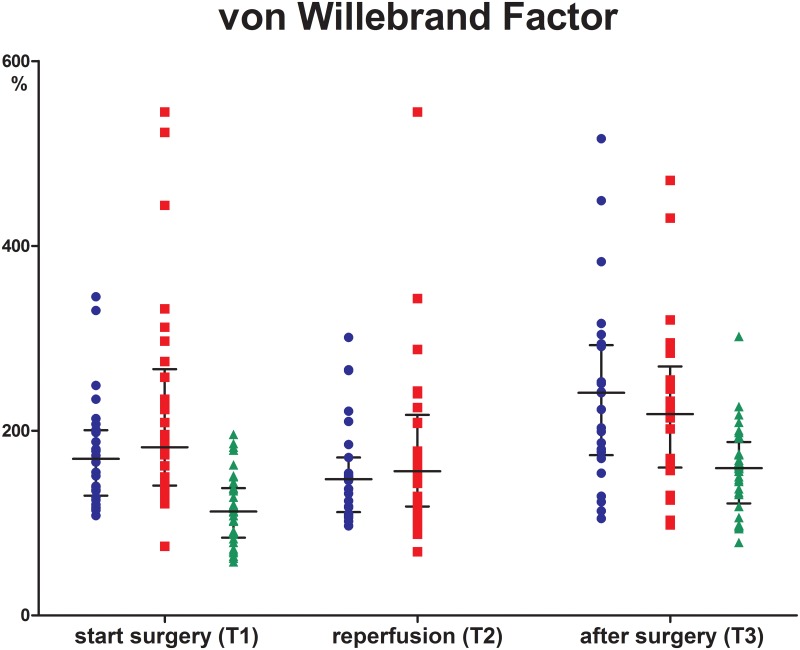
Von Willebrand Factor.Preemptive group (blue triangle), non-preemptive group (red square) and donors (green dot) before incision (T1), 5 minutes after reperfusion (T2) and 2 hours after surgery (T3). Data are given as medians with IQR.